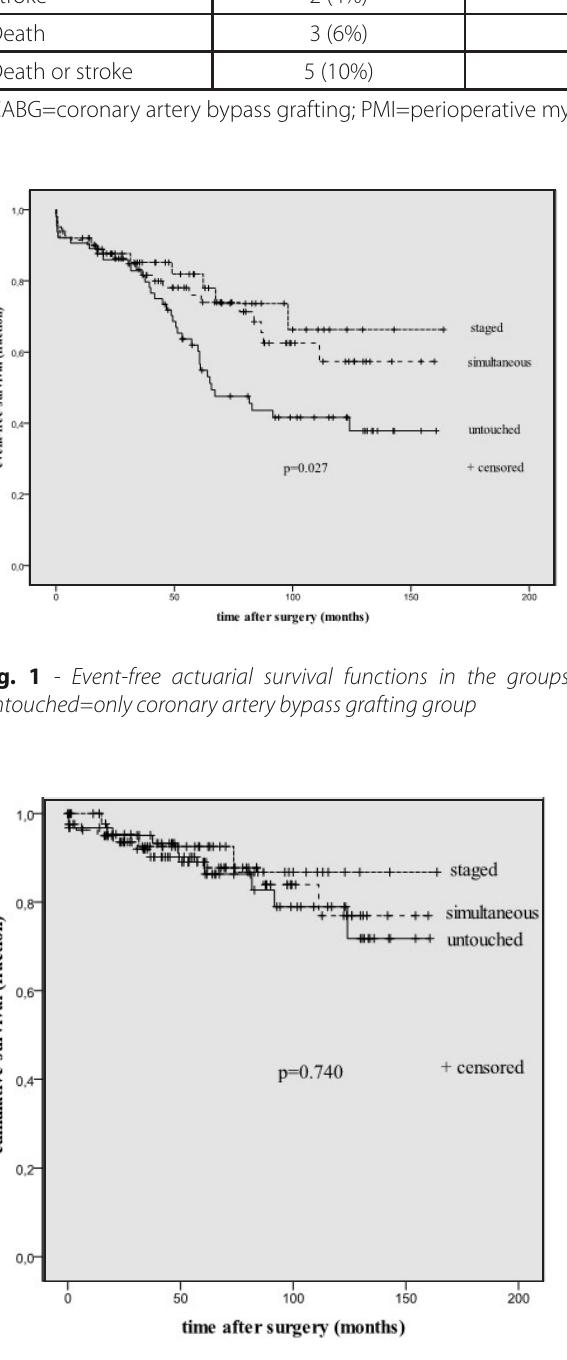
Fig. 2 - Cardiac-related event-free survival curves of groups.